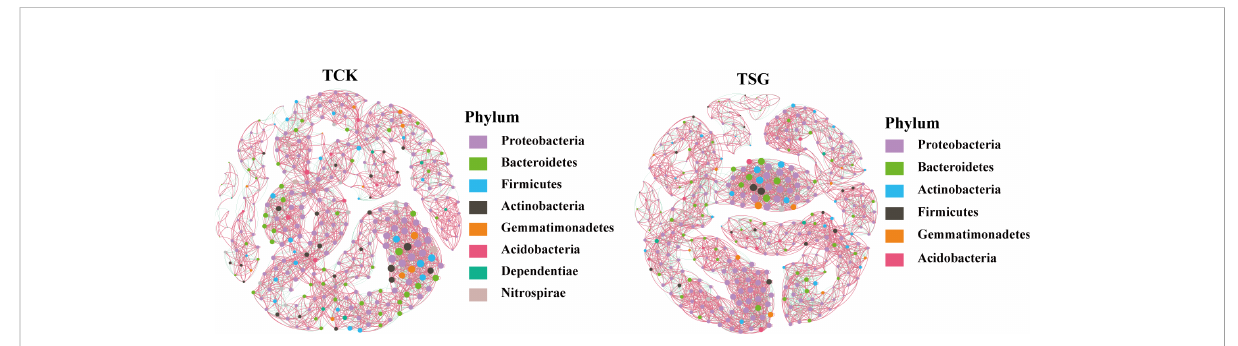
FIGURE 5 Co-occurrence networks between bacterial taxa based on genus at the Phylum level according to the Pearson correlation coef fi cients in sample TCK and TSG (Nodes labeled with the same color indicate that different genus belonged to the same bacterial Phylum; node size indicates link numbers with other nodes and larger sizes indicate more link numbers; the edge represents the connected line between two nodes with signi fi cant correlation (Pearson ’ s correlation coef fi cient > 0.6, P< 0.05); the red and green lines within the two nodes in the networks represent positive and negative correlations, respectively.).